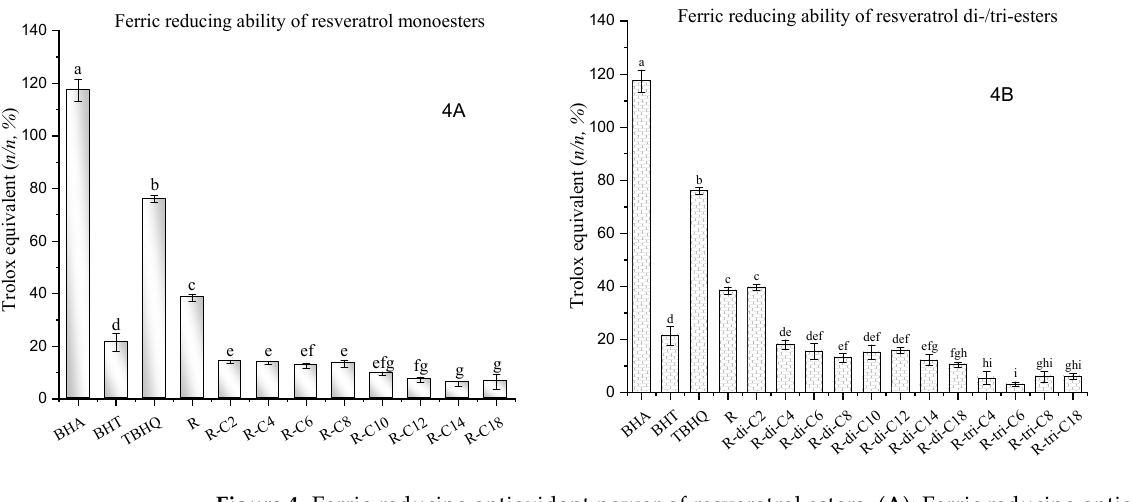
Figure 4. Ferric-reducing antioxidant power of resveratrol esters. ( A ): Ferric reducing antioxidant power in mole efficacy equivalent of Trolox per mole of resveratrol (R) or its monoesters (%, n/n ). R-C2, R-C4, R-C6, R-C8, R-C10, R-C12, R-C14, R-C18 are resveratrol esters of acetic, butyric, caproic, caprylic, capric, lauric, myristic, and stearic acids, respectively. ( B ): Ferric reducing antioxidant power in mole efficacy equivalent of Trolox per mole of resveratrol (R) or its di-/triesters (%, n/n ). R-di-C2, R-di-C4, R-di-C6, R-di-C8, R-di-C10, R-di-C12, R-di-C14, and R-di-C18 are resveratrol diesters of acetic, butyric, caproic, caprylic, capric, lauric, myristic, and stearic acids, respectively; R-tri-C4, R-tri-C6, R-tri-C8, and R-tri-C18 are resveratrol triesters of caproic, caprylic, capric, and stearic acids, respectively. Each assay was replicated 3 times. Entries with different letters were significantly different at p < 0.05, performed by Tukey’s HSD